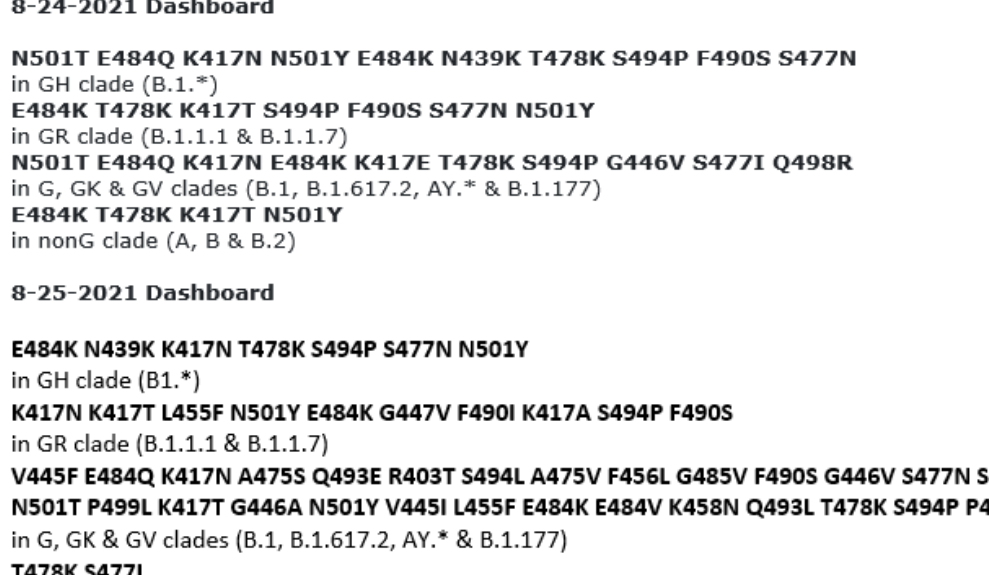
Figure 1. This is a figure showing GISAID hCoV-19 S protein mutation surveillance dashboard data on 24 and 25 August 2021 .